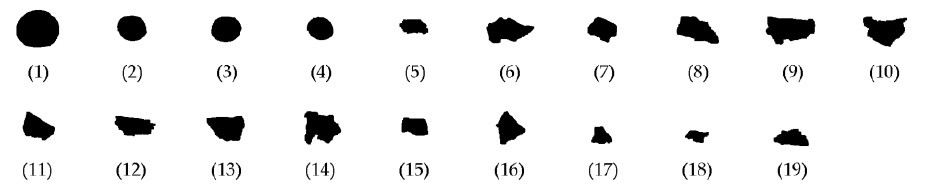
Figure 12. Scrap images acquired during testing. Sensors 2018 , 18 , x FOR PEER REVIEW